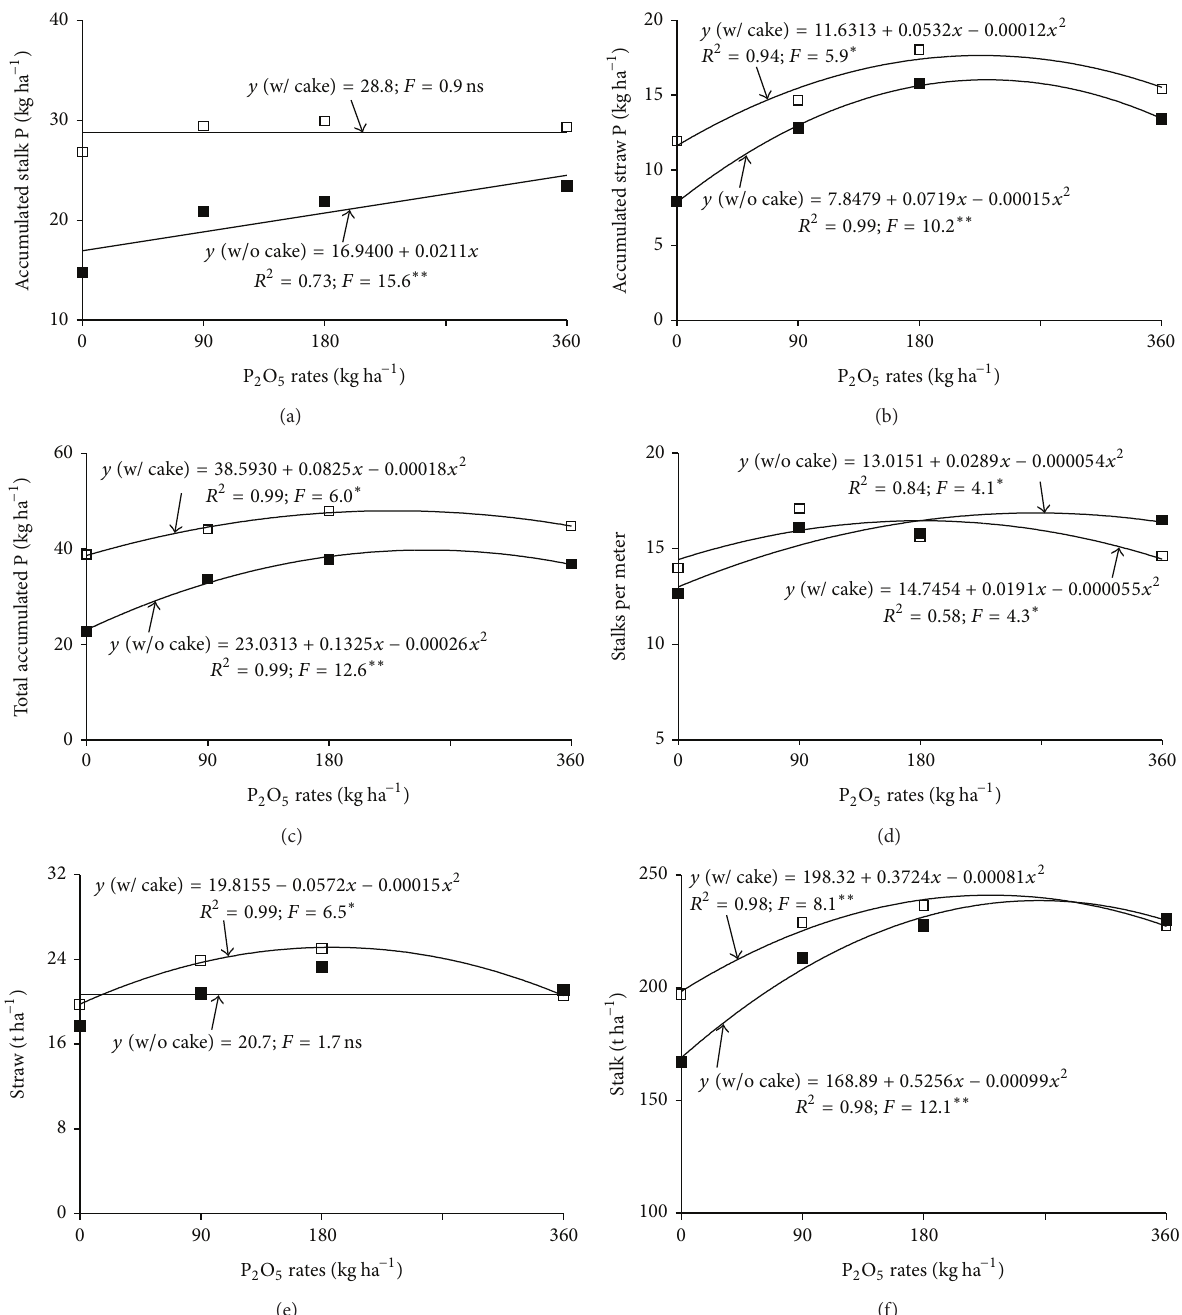
Figure 5: Phosphorus accumulation in stalks (a), straw (b), and total (c), number of stalks per meter (d), and productivity of sugarcane straw (e) and stalks (f) as a function of phosphorus application rate. ∗∗ , ∗ and ns: significant at 0.01, 0.05 and insignificant, respectively.